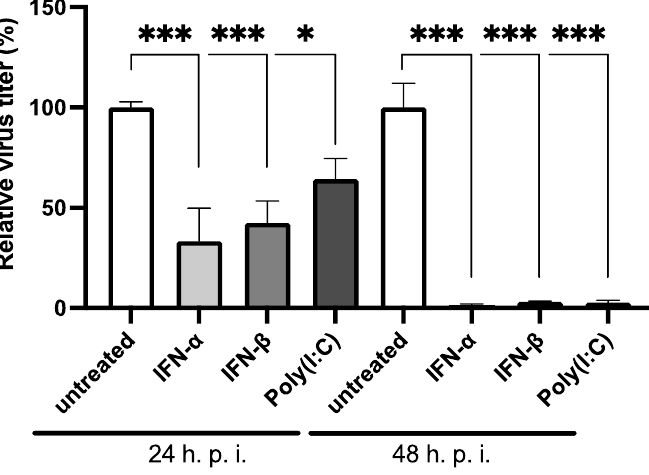
Figure 5. Infection of stimulated M Φ with LASV. M Φ were stimulated with 500 U/mL IFN- α , or IFN- β or Poly(I:C) and sixteen hours post-stimulation, they were infected with LASV with an MOI of 0.1. The cell culture supernatant was collected 24 or 48 h post-infection (h. p. i.) and used for immunofocus assay. The virus titres are shown relative to their uninfected controls. The experiment was performed in triplicate. Shown are the mean and standard deviation. Differences in virus titres were analysed with one-way ANOVA and Bonferroni’s multiple comparison test. *, p < 0.033; ***, p < 0.001.